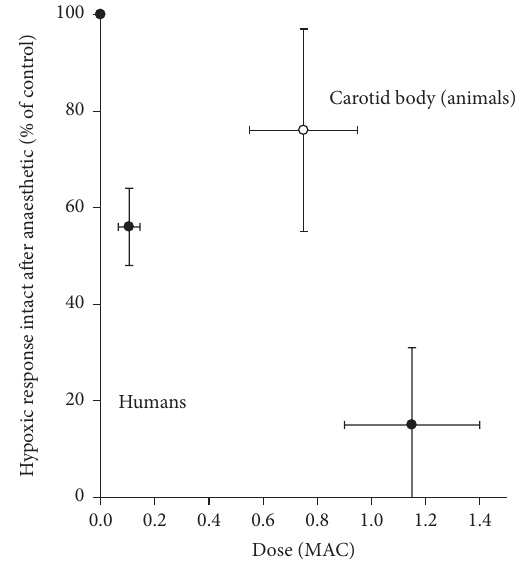
Figure 4: Plot of dose-response relationships between the effect of anaesthetic on hypoxic response, expressed as the % hypoxic response intact in presence of agent versus MAC for animal carotid bodies (this study from Table 1), human data at low dose (data from reference [5]), and human data at high dose (data from references [1–4, 9–11, 20, 21, 72]). The points are means ( ± 95% confidence